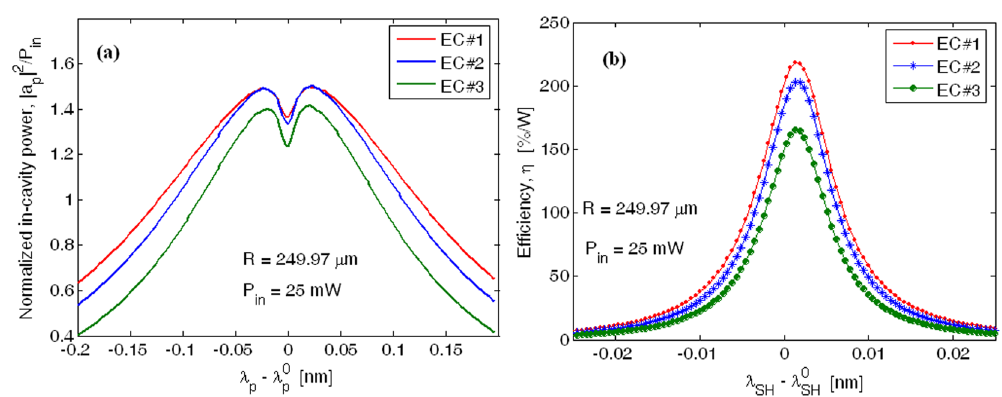
Figure 9. Spectrum as a function of the wavelength mismatch. ( a ) Normalized in-cavity pump power. ( b ) SH